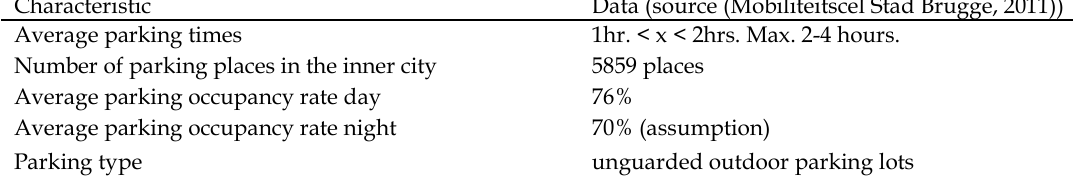
Parking characteristics for the inner city of Bruges